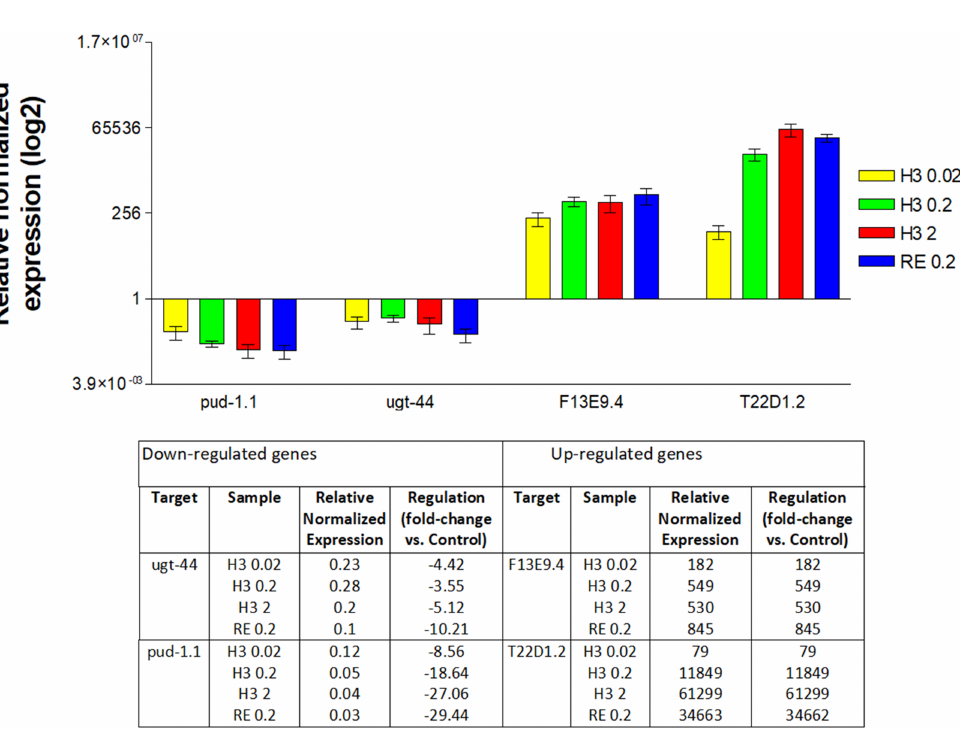
Fig 2. Quantitative RT-PCR. Relativenormalized expressionof ugt-44 , pud-1 . 1 , F13E9.4 and T22D1.2 mRNA followingthe treatment with OPC enrichedfraction “H3” or C . mucronatum extract (ethanol: water 1:1; “RE”); 0.02, 0.2 and 2: concentrations of 0.02 mg/mL, 0.2 mg/mL and 2 mg/mL respectively. Data are presentedon a log2 scale, the line at 1.0 indicatesthe expressionlevel of the negativecontrol (DMSO